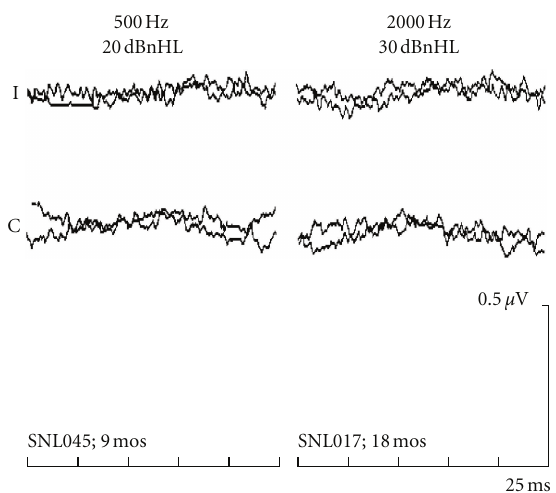
Figure 2: “Elevated” ABR results (i.e., no response at normal inten- sities) for 500- and 2000-Hz BC tones recorded from two infants with sensorineural hearing loss. Age at ABR testing indicated on the bottom. On behavioural follow up, both infants had sensorineural hearing